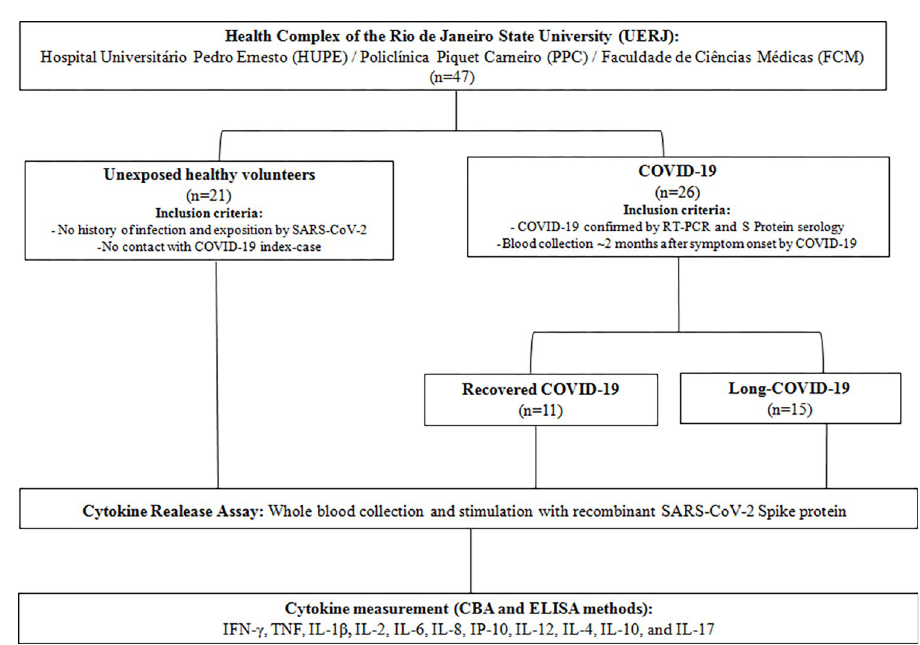
Fig 1. Study design. Flow chart showing recruitment sites, eligibility criteria for selecting volunteers, and methodologies used for sample processing.